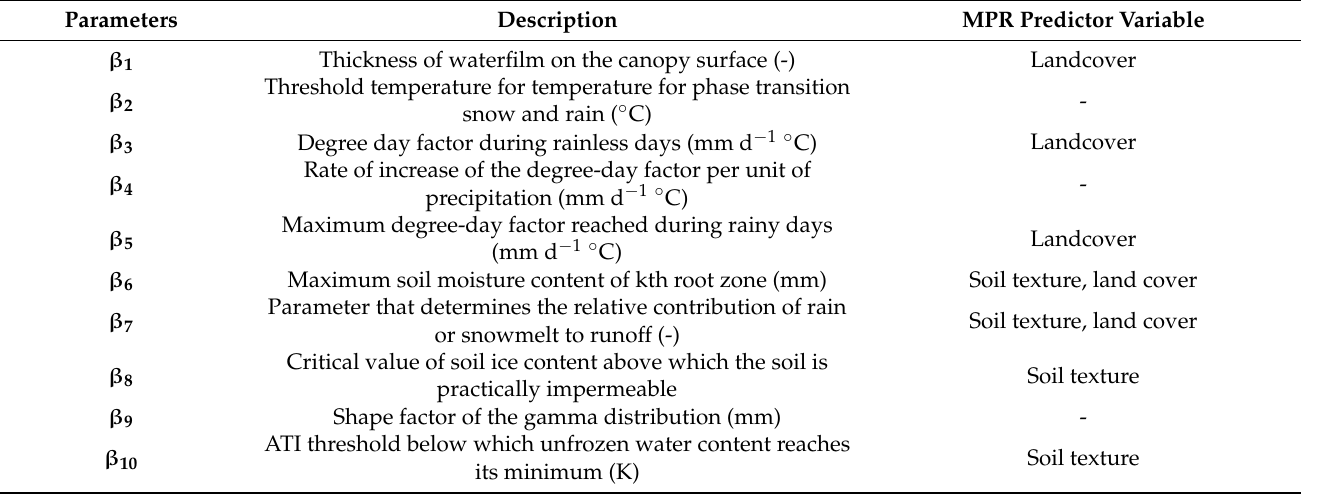
Table A1. List of mHM Parameters and their predictor